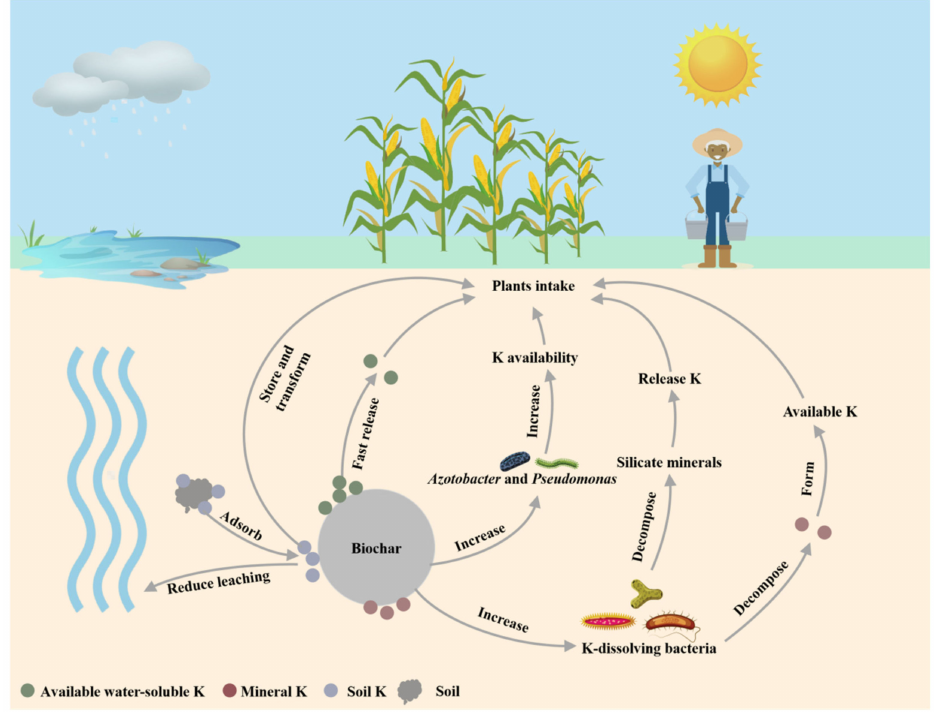
Figure 3. The mechanisms of biochar application on K improvement in soil